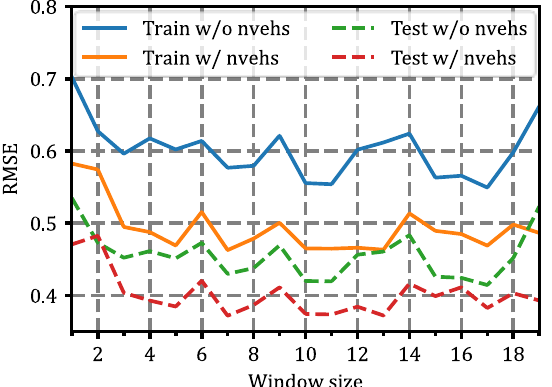
Figure 9. Results of the latency forecast module for both the train and test datasets. The results are shown with the vehicle number variable (w/nvehs) and without it (w/o nvehs) as input parameters in the latency forecaster module.